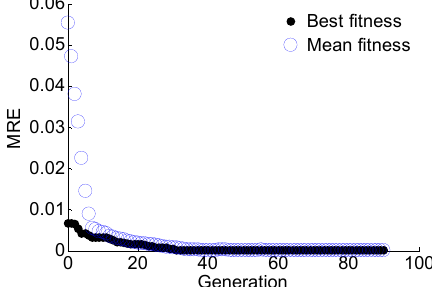
Figure 13. The optimization process using GA for model parameters.